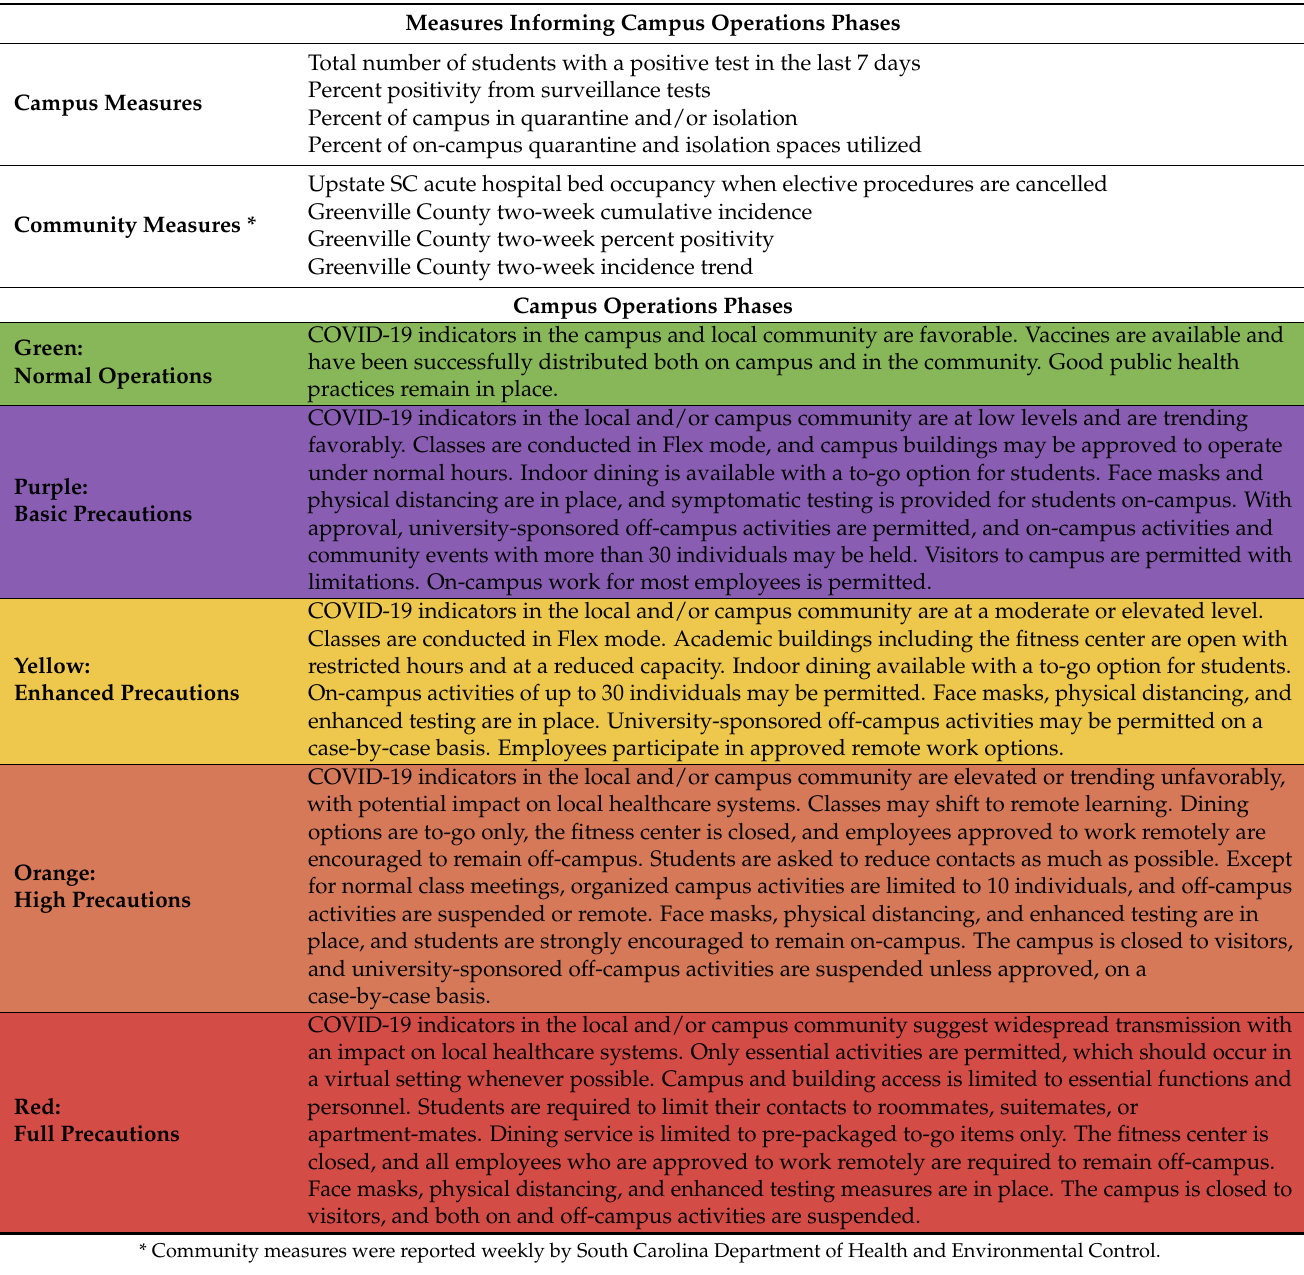
Table 2. COVID-19 measures used to determine operational phases and campus activities in operational phases in Spring 2021 at a university—South Carolina, January–April